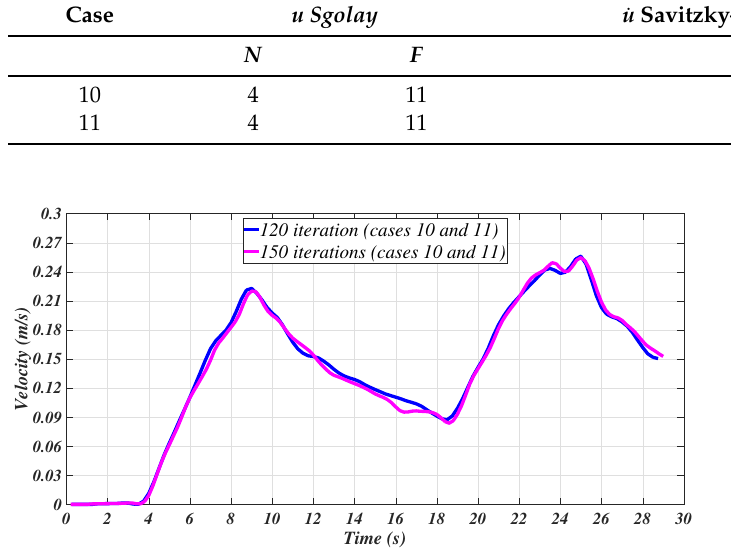
Figure 11. Filtered velocities with the Savitzky–Golay method.